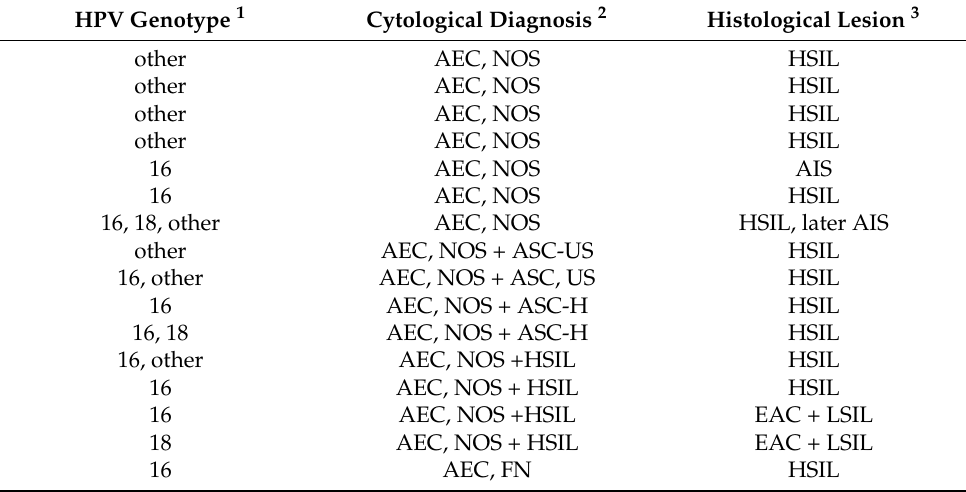
Table 1. The high-grade histological lesions detected on the two screening rounds during 2012–2015 and 2017–2020, including the hrHPV genotypes and the initial cytological